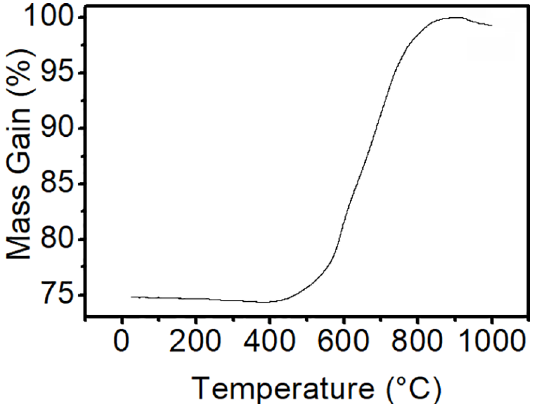
Figure 1. Thermogravimetry Measure (TG) of xerogel under air